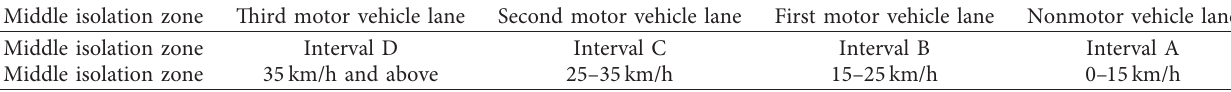
Table 1: Interval division diagram of road lanes occupied by e-bike riders.